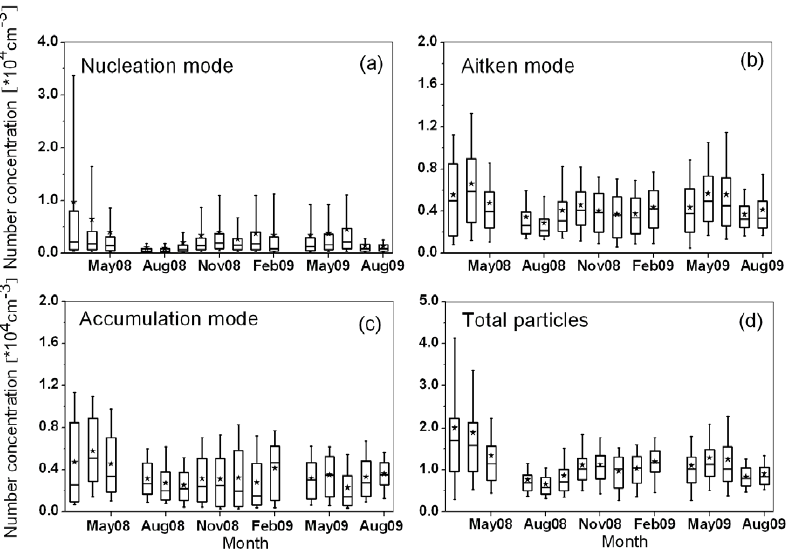
Fig. 2. Monthly variation of number concentration for nucleation mode (a) , Aitken mode (b) , accumulation mode particles (c) and total particles (d) at SDZ. The box plots are read as follows: the upper and lower boundaries of the box indicate the 75-th and the 25-th percentiles, the line within the box marks the median, and the whiskers above and below the box indicate the 90-th and 10-th percentiles. The stars represent the mean values. There was no data available for June 2008 and March 2009.